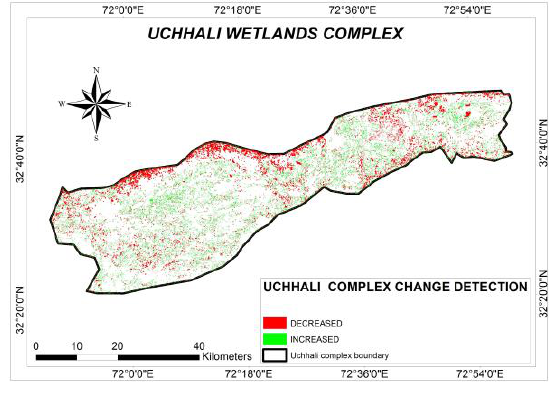
Figure 5. Map showing areas of notable change from 2006 to 2016